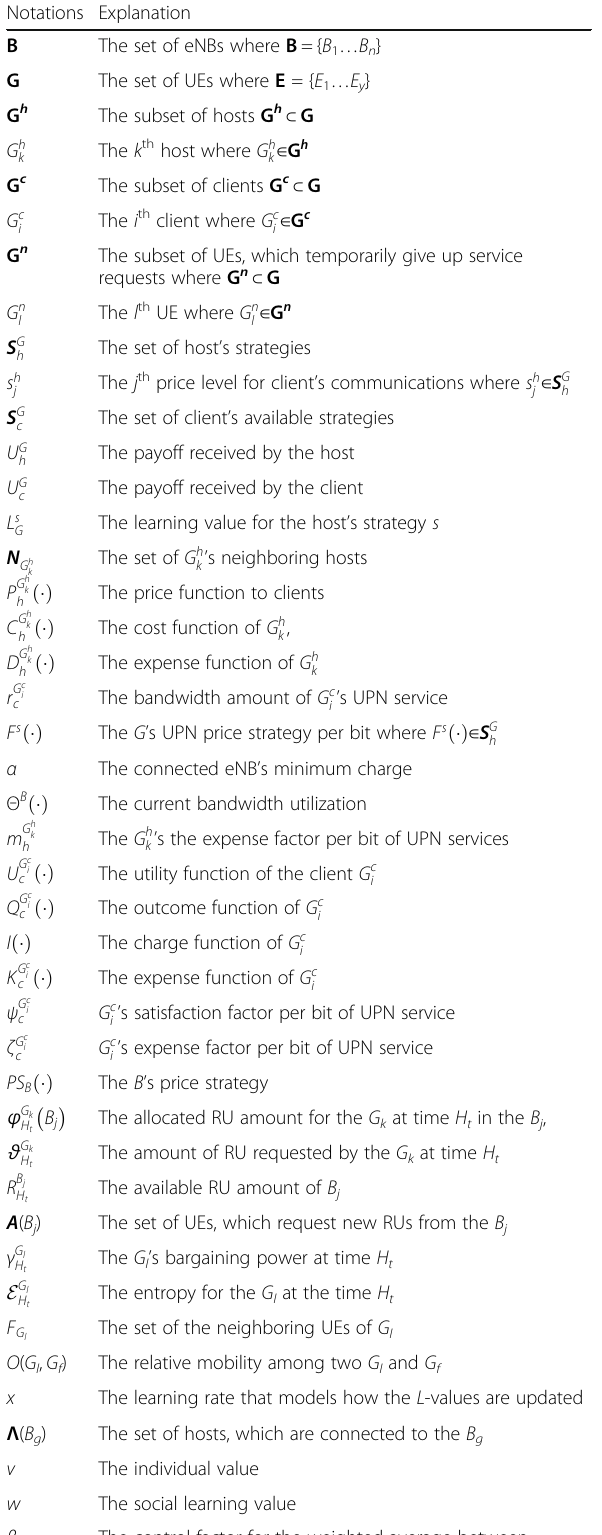
Table 1 Parameters used in the proposed algorithm Notations Explanation